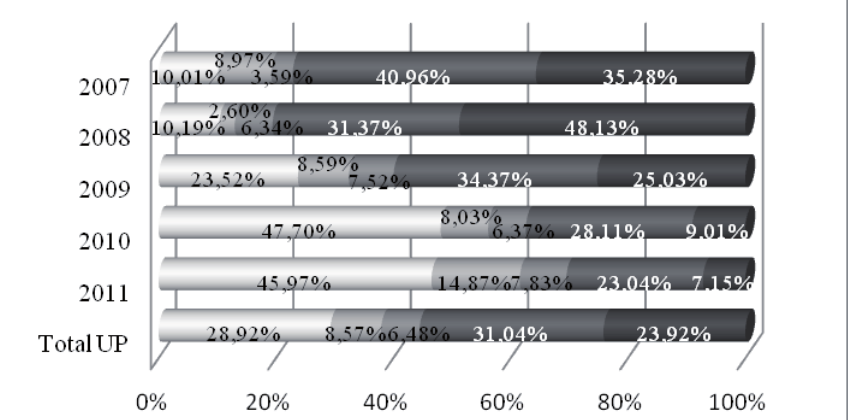
Figure 2. The graduates’ study program level,